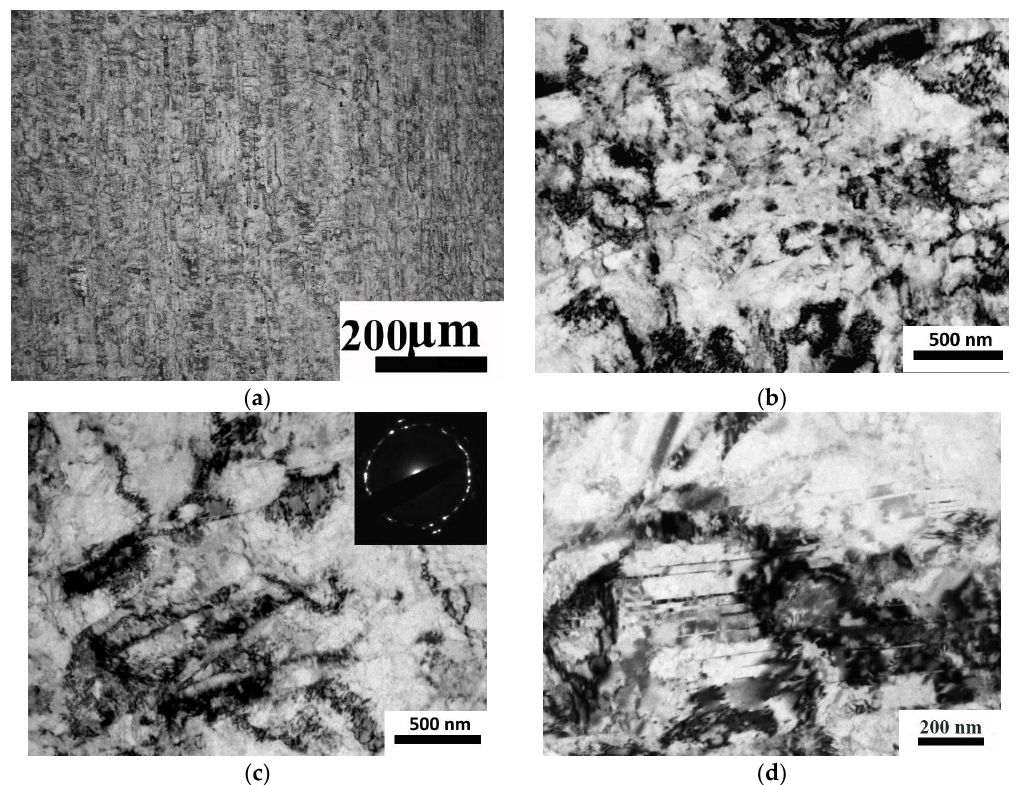
Figure 4. Structure of the austenitic steel after ECAP and subsequent rolling to a total reduction in area of 77% (“ECAP + Rol” condition): ( a ) optical microscopy; ( b – d ) TEM, the aperture size for diffraction patterns ~1 μm 2 .